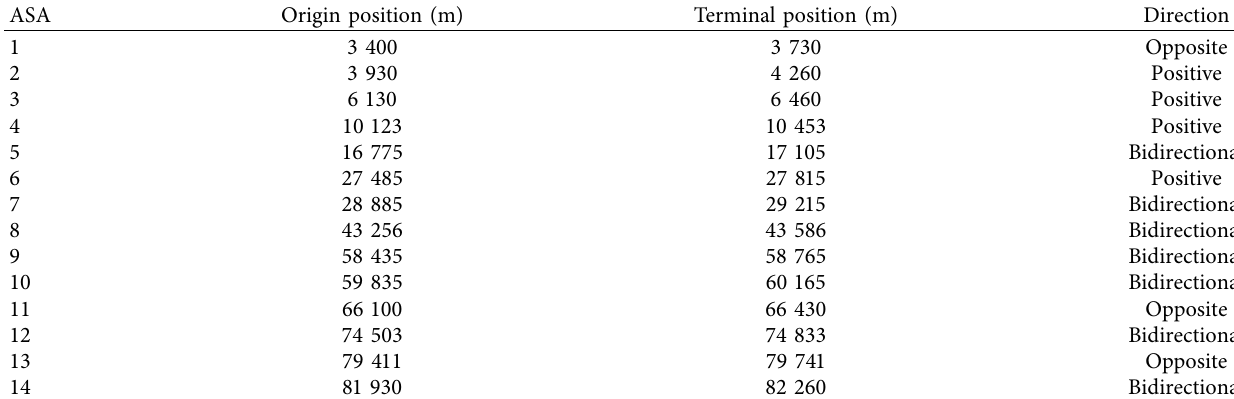
Table 3: ASA positions considering the two directions coordinately.